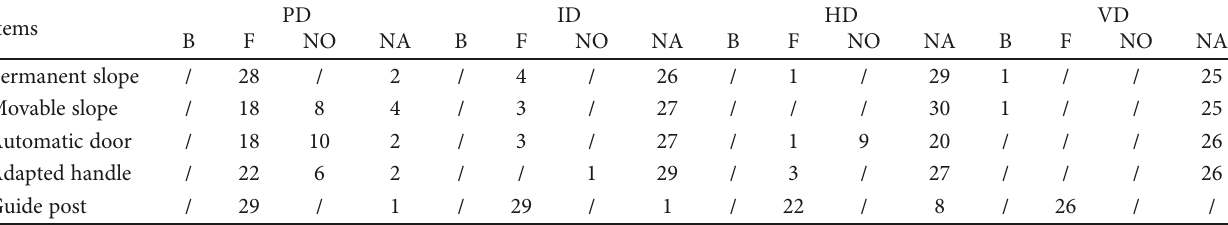
Table 7: Facilitators and barriers of AT for school